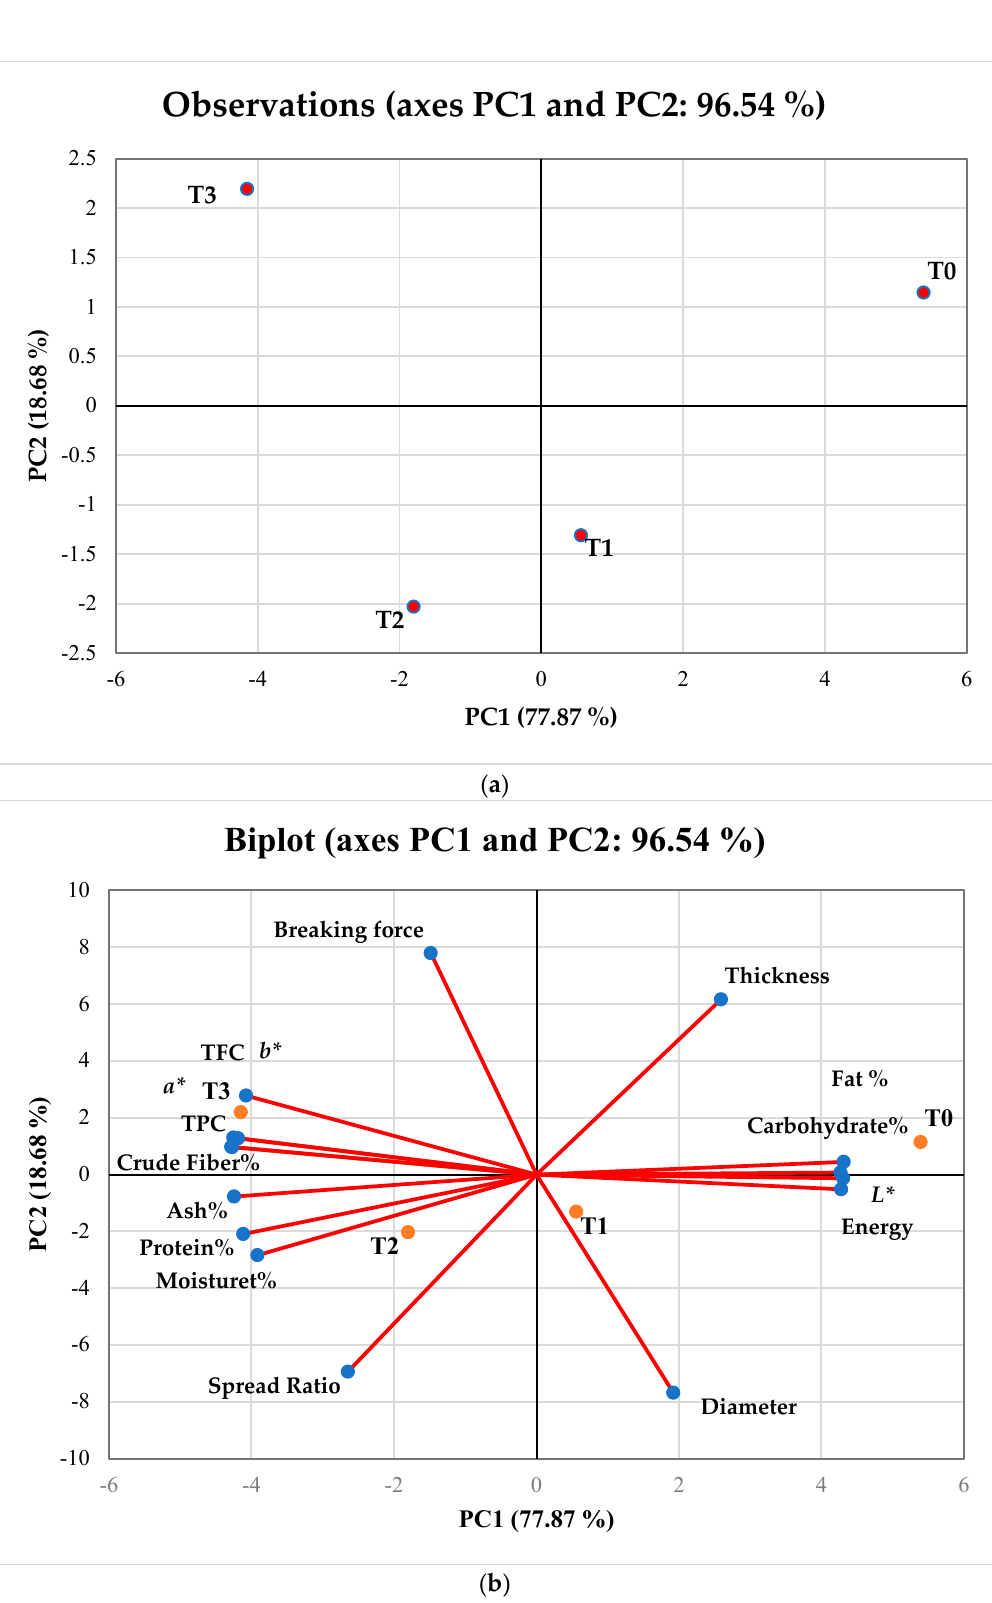
Figure 4. ( a ) Principal component analysis with the location of biscuit samples: T0; RF (rice